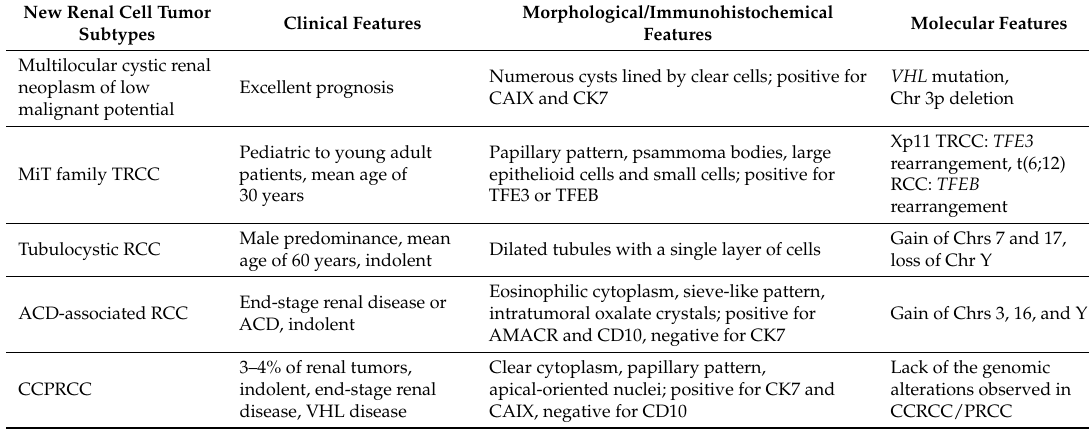
Table 3. New subtypes of renal cell tumors in the 2016 WHO classification